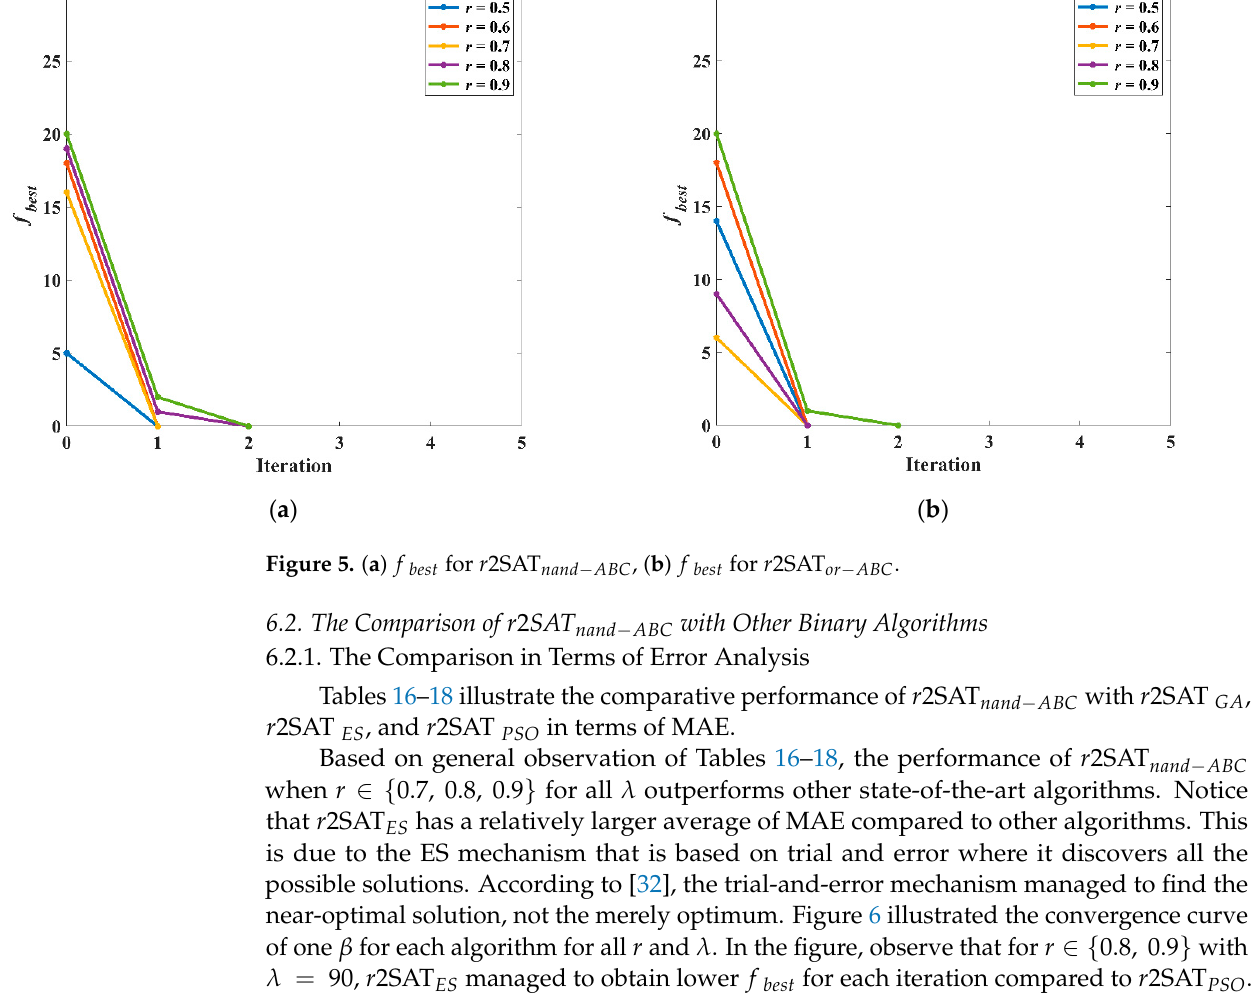
Table 16. Comparison of − 2SAT nand ABC r against other binary algorithms in terms of MAE for 10 λ = .